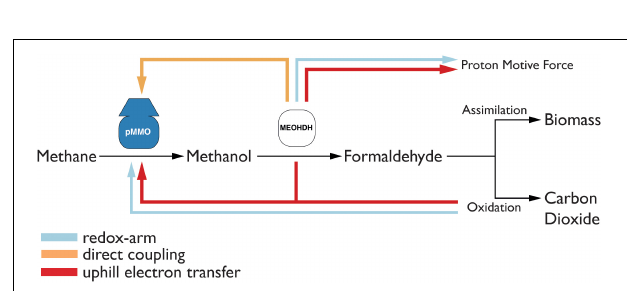
FIGURE 2 | The three possible modes of electron transfer to the pMMO. (1) Redox-arm : The methanol dehydrogenase transfers electrons to the terminal oxidase which contributes to increasing the proton motive force (PMF), while the pMMO draws electrons from the quinone pool. (2) Direct coupling : Electrons from the oxidation of methanol are transferred directly to the pMMO. (3) Uphill electron transfer : Electrons from the methanol dehydrogenase feed back into the